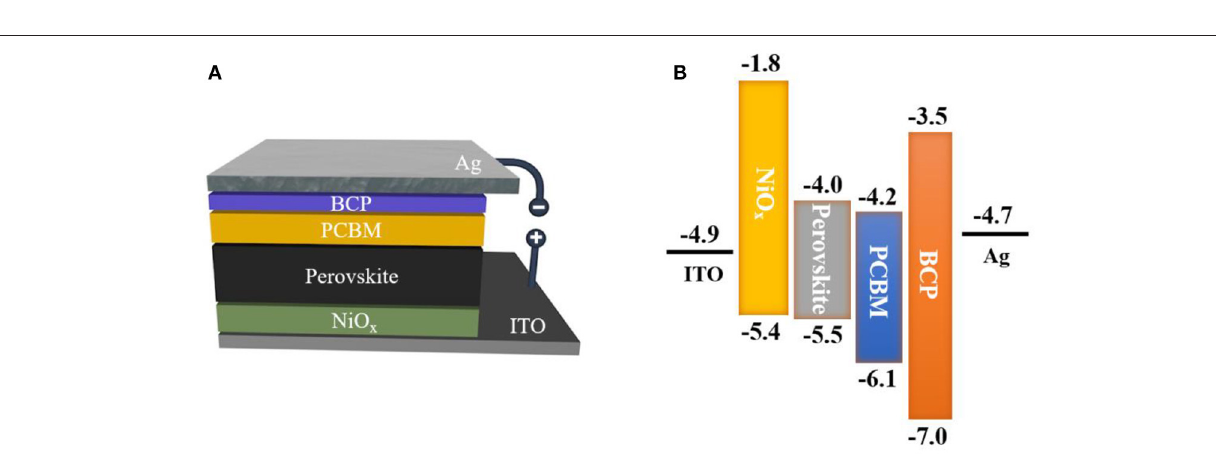
FIGURE 3 | Schematic diagrams of (A) The device structure of ITO/NiO x /Perovskite/PCBM/BCP/Ag; and (B) the band energy diagrams for the inverted structured perovskite solar